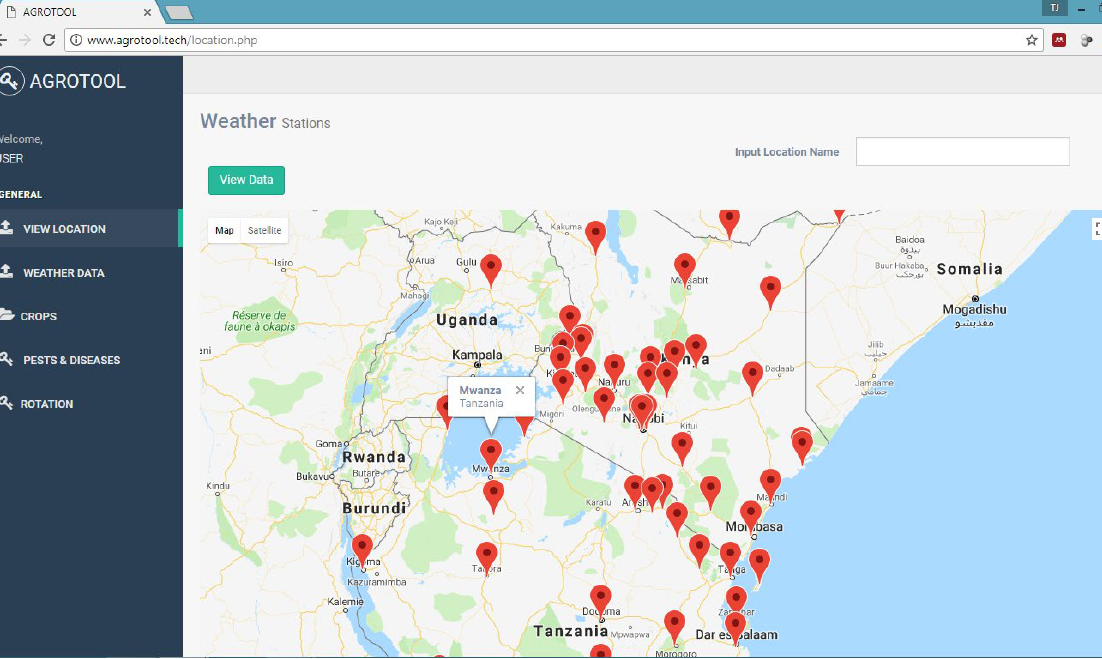
Figure 3. Tanzania weather stations to allocated weather data of different locations stored in the